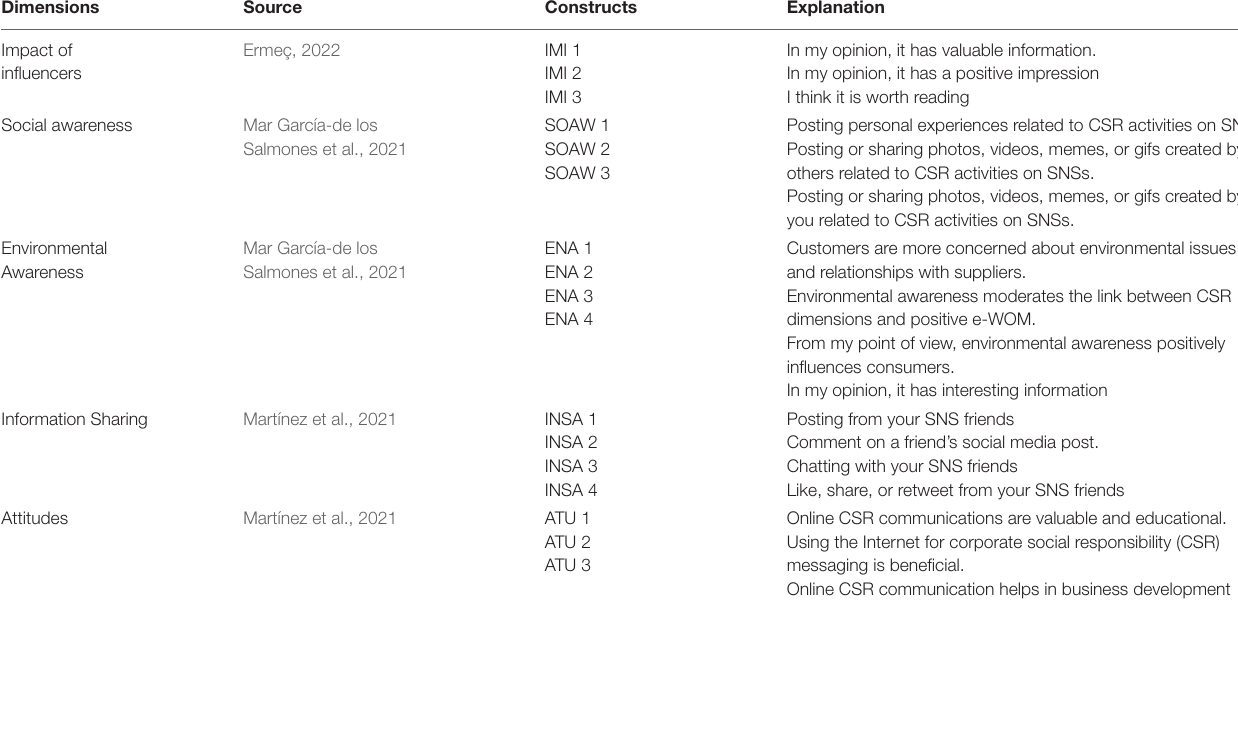
TABLE A1 | Measurement